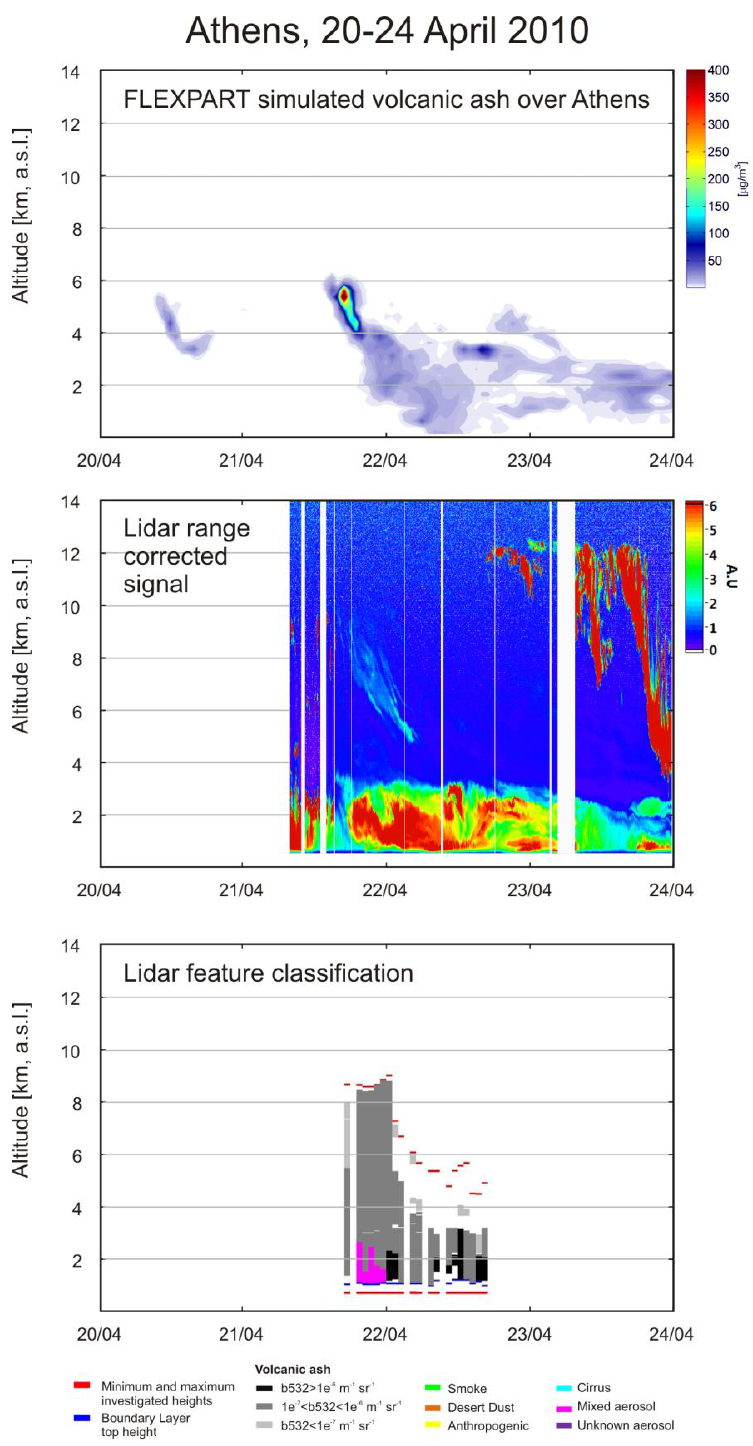
Fig. 2. (upper graph) Time–height contours of volcanic ash concentrations (in µgm − 3 ) over Athens from 20 April 2010 at 00:00UTC to 24 April 2010 at 00:000UTC, as simulated by FLEXPART. (middle graph) Temporal evolution of the range-corrected lidar signal (RCS) in arbitrary units (A.U.) obtained over Athens at 1064nm, between 21 (07:00UTC) and 24 April 2010 (03:00UTC). All colored structures correspond to the presence of aerosols, except after 22 April 2010 (15:00UTC), where clouds are detected at heights between 4 and 12.5km. (lower graph) Aerosol masking for the particle layers detected over Athens from 21 (16:00UTC) to 22 April 2010